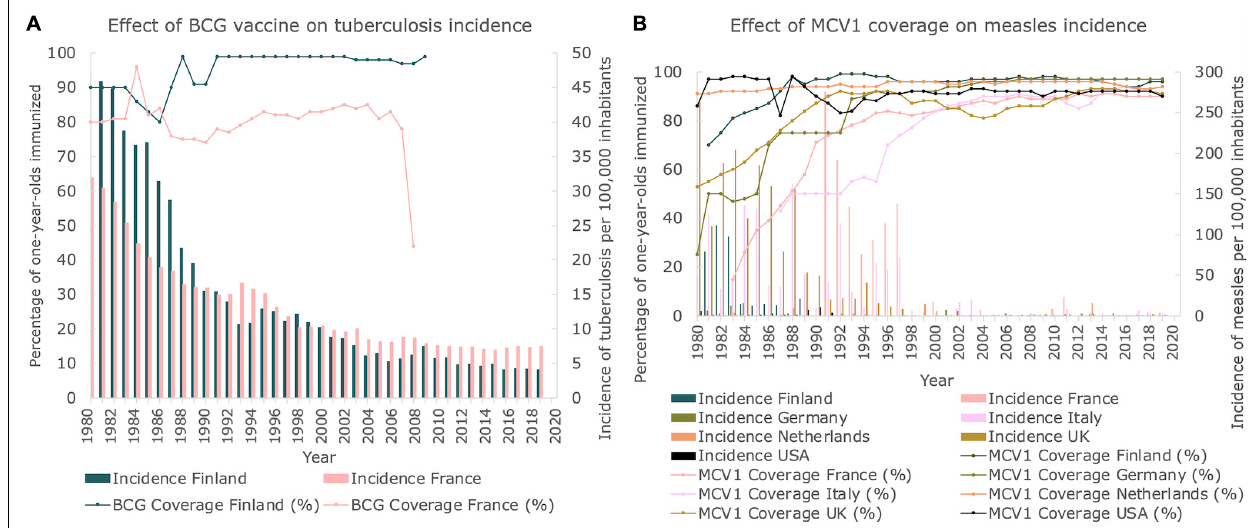
FIGURE 4 | Vaccination coverages for TB and measles. (A) Vaccination coverage of BCG vaccine and corresponding incidence of TB in Finland and France between 1980 and 2019. Line graphs represent the BCG vaccination coverage. Bar graphs represent the incidence of TB per 100,000 inhabitants. (B) Percentage of 1-year-olds immunized with MCV1 per country between 1980 and 2019. Line graphs represent the MCV1 vaccination coverage. Bar graphs represent the incidence of measles per 100,000